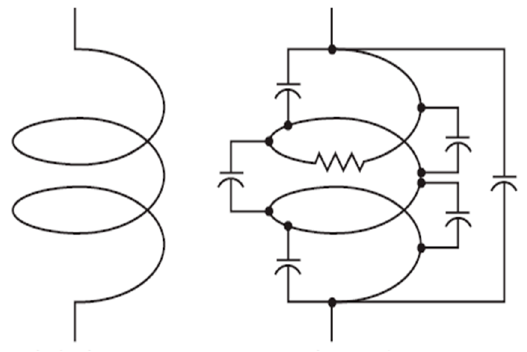
Figure 2. Coil: ideal inductor ( left ), inductor with stray capacitance and resistance ( right ) .